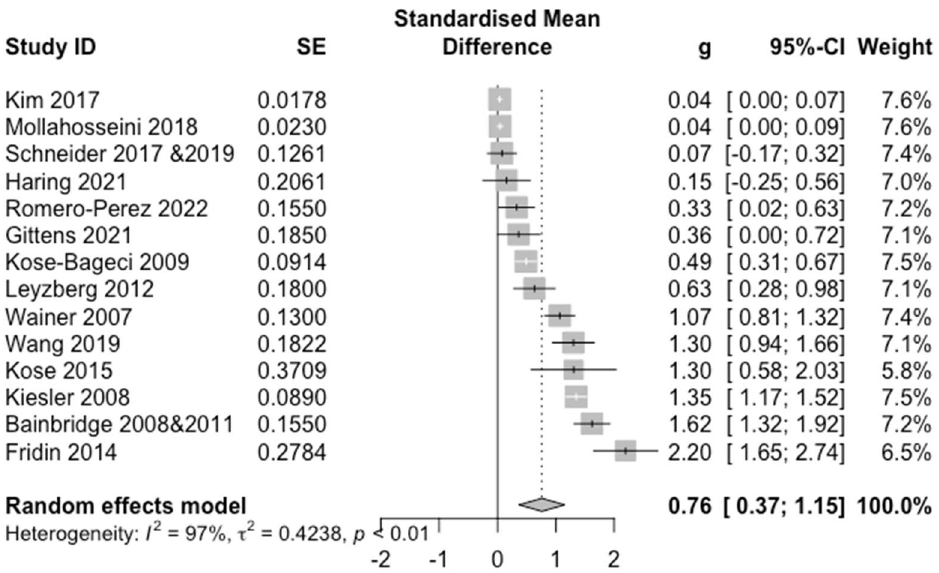
Figure 3. Forest Plot of Overall Effect. For each study and the average effect size, the plot shows standardised mean differences (hedges’ g), standard error (SE), the 95% confidence interval (95% CI), and the weight in the random effect model. Heterogeneity is represented by the between study Higgins & Thompson’s 𝐼 (cid:2870) , heterogeneity variance 𝜏 (cid:2870) and p -value.